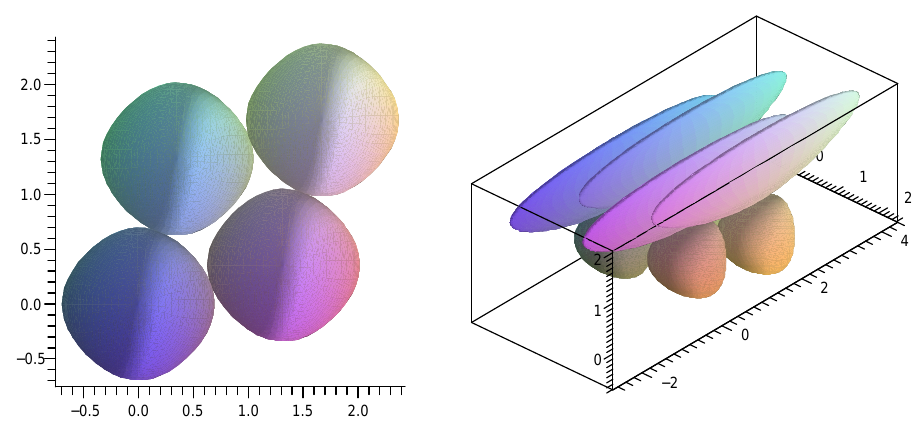
Figure 9. The optimal translation ball arrangement by fundamental lattices in Sol space.